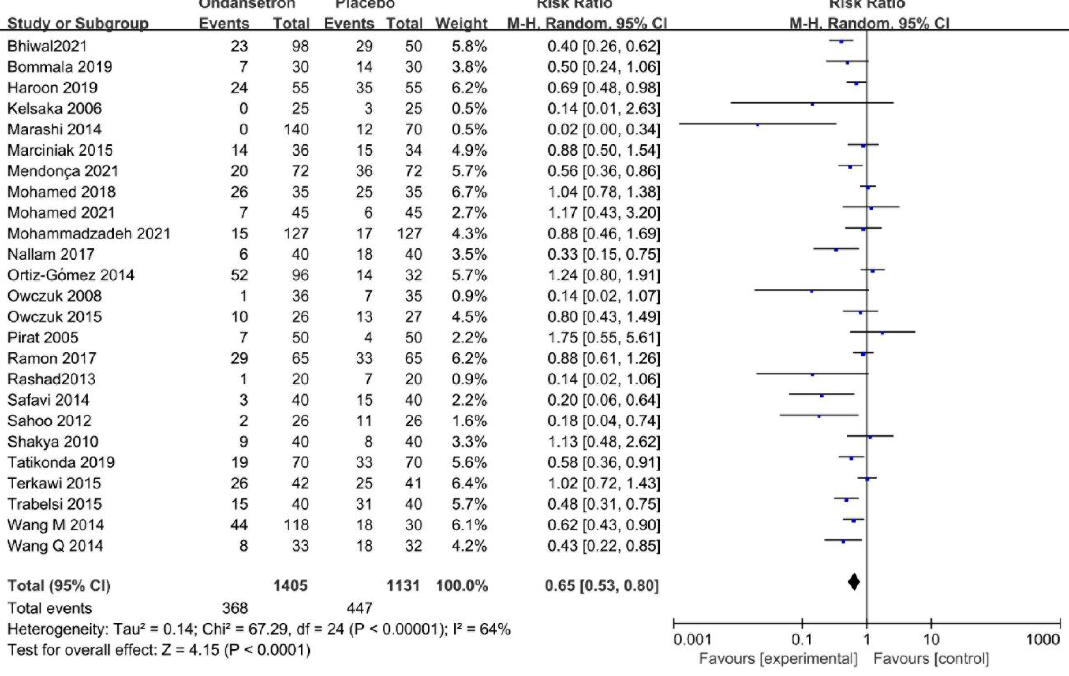
Figure 3. Forest plot of the pooled analysis showing the incidence of hypotension.[2, 11-13, 30-50]